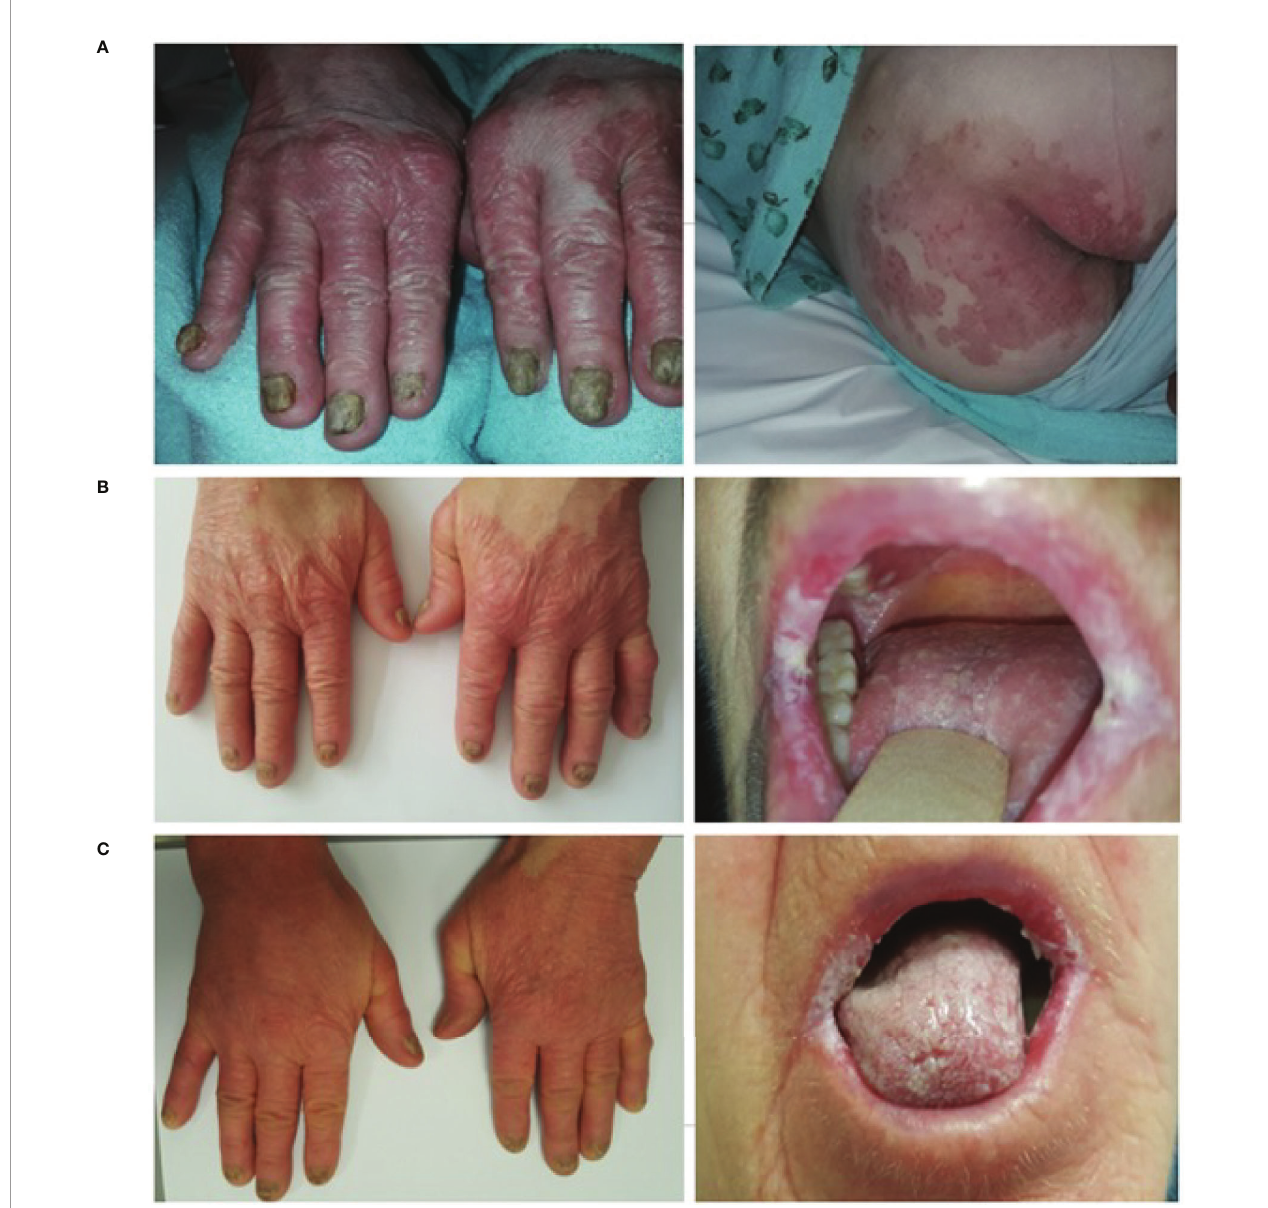
FIGURE 1 | TAMA. Skin and mucosal lesions photographed (A) at the onset of chemotherapy, (B) after six cycles of systemic treatment and (C) after three months of prednisone